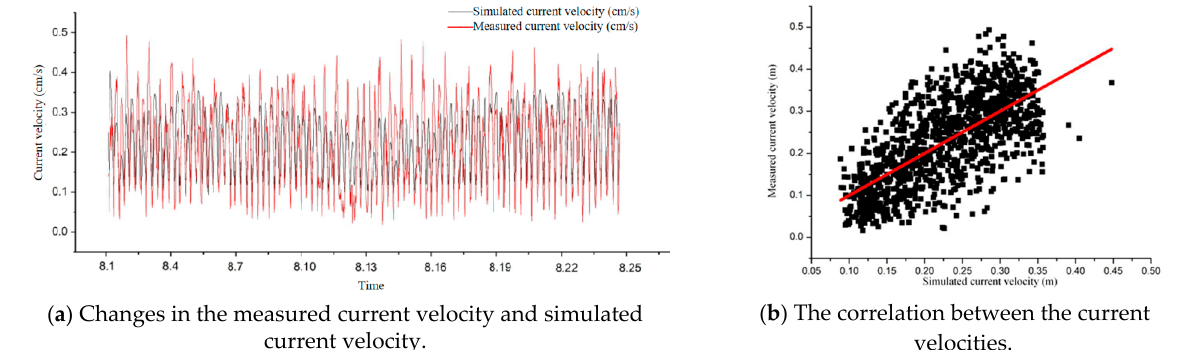
Figure 6. Changes in ( a ) and correlation between ( b ) the measured current velocity and simulated current velocity over time (Pearson’s r = 0.69). current velocity over time (Pearson’s r =